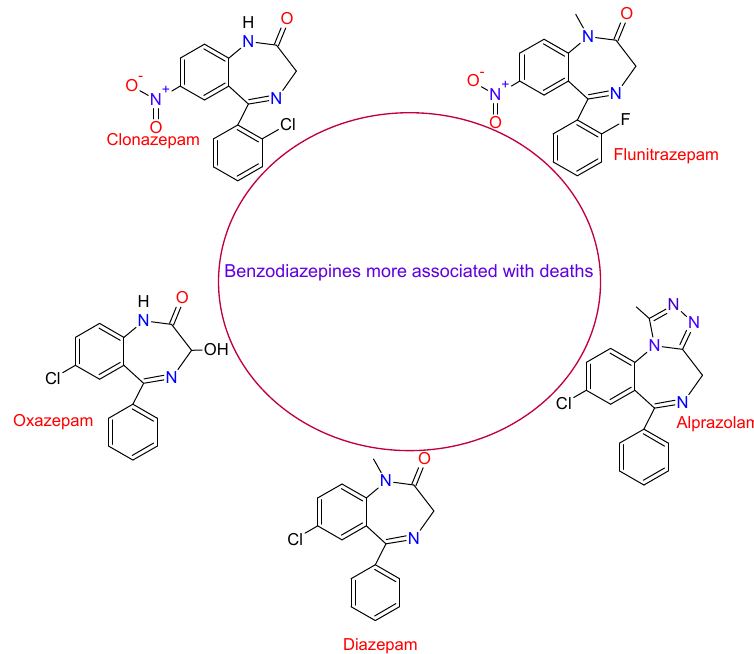
Figure 10. Structure of the benzodiazepines more linked to deaths.